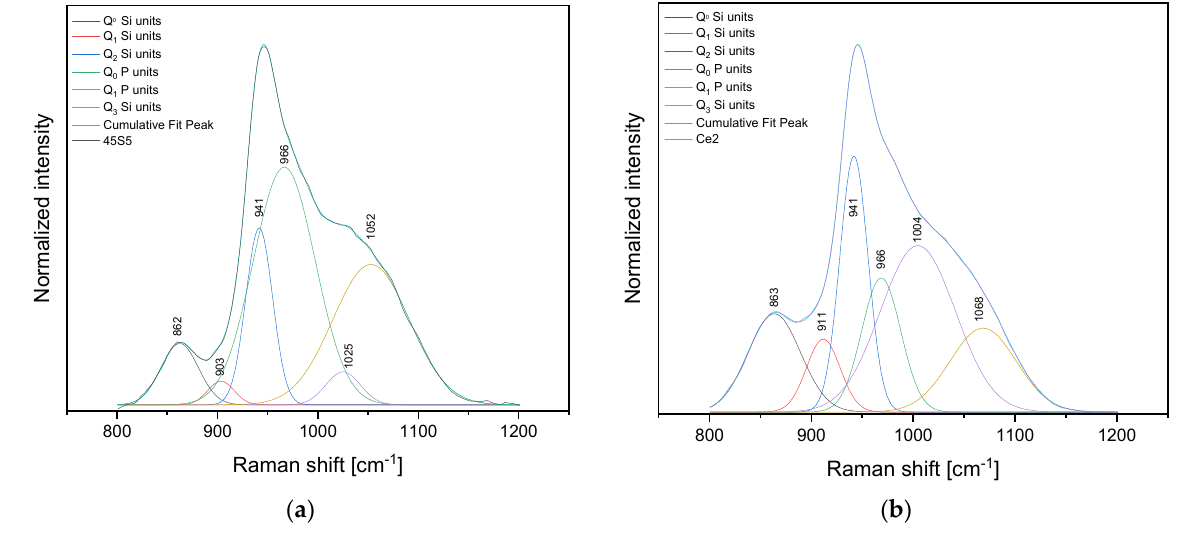
Figure 4. Deconvolution of Raman spectra for the ( a ) 45S5 and ( b ) Ce2 samples (R 2 >0.999). Table 1. Band areas of Q 0 Si units, Q1 Si units, Q 2 Si units, Q 0 P units, Q 1 P units and Q 3 Si units.